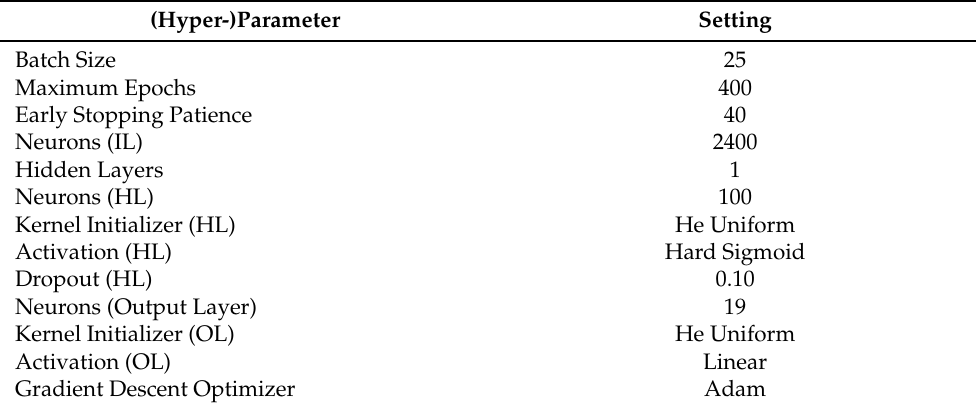
Table A4. Default Neural Net settings.